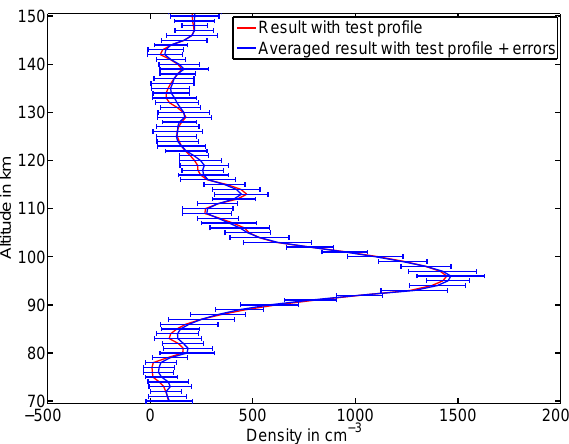
Fig. 22. Mg + (279.6nm) retrieval result. The same methods as in Fig. 21 are applied. The errors for Mg + are smaller than for Mg and furthermore nonlinear self-absorption effects are smaller for Mg + . Therefore, both methods lead to the same mean results.